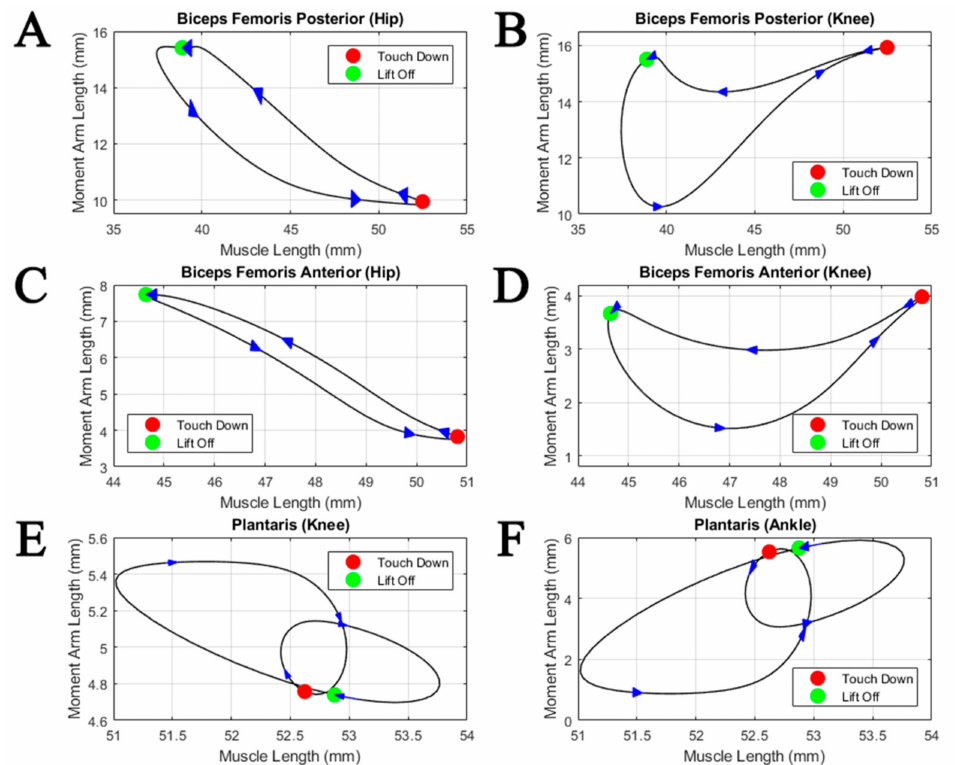
Figure 9. Biarticular moment arm profiles with respect to muscle length during simultaneous multijoint motion under a physiological walking pattern. Two moment arm profiles are provided for ( A,B ) the biceps femoris posterior, ( C,D ) biceps femoris anterior, and ( E,F ) plantaris, representing analysis about either spanned joint. Arrows indicate increasing step cycle direction (from stance to swing) with equal time spacing, and colored dots represent touch down (red) and lift off